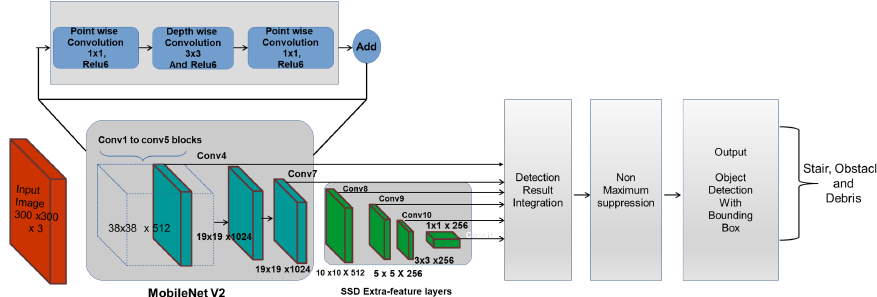
Figure 6. SSD MobileNet V2 Object Detection